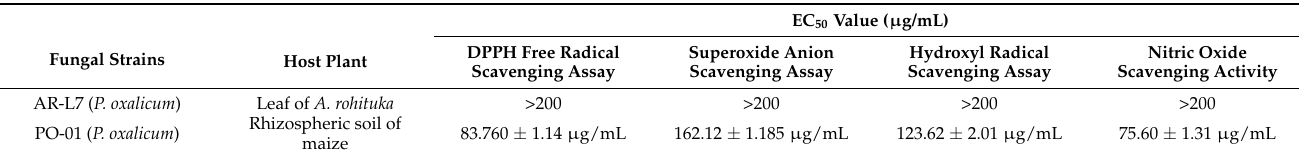
Table 4. Host-dependent antioxidant activity of EA extract of fungal endophyte P. oxalicum (AR-L7) and